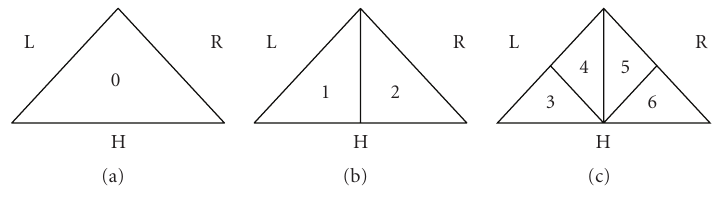
Figure 3: Neighbourhood map structure.